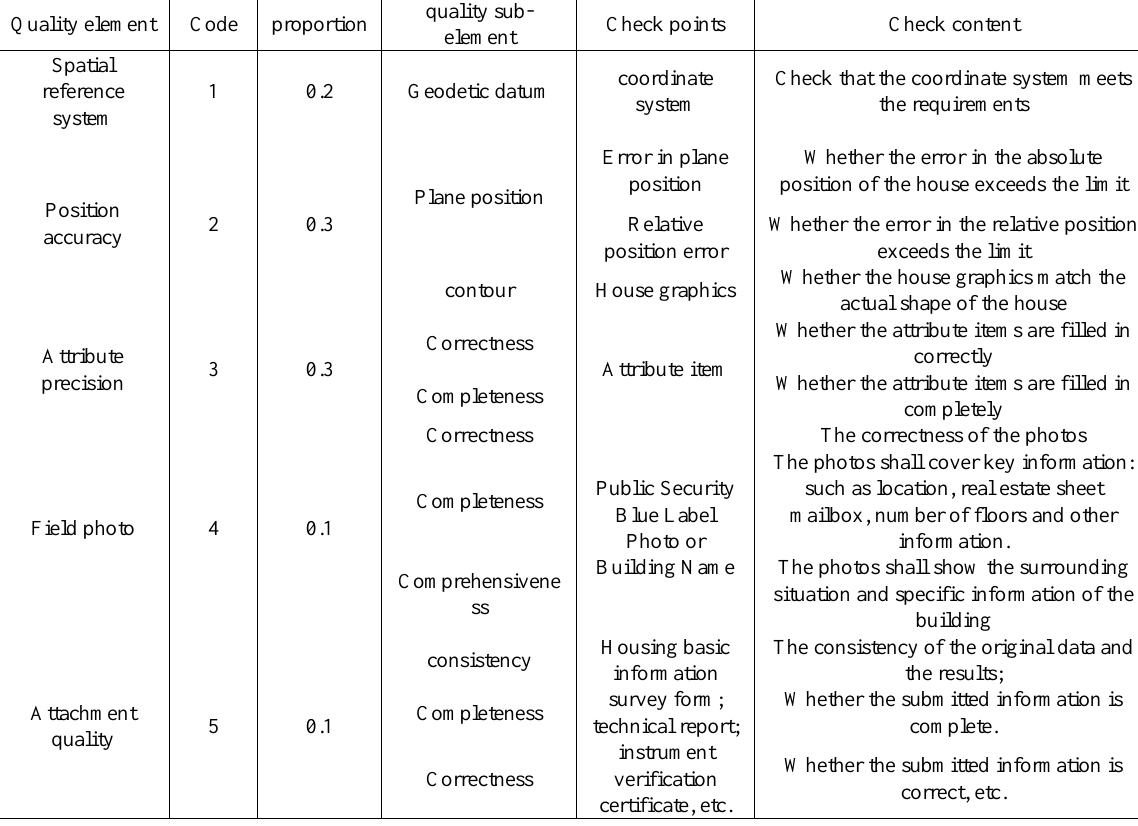
Table 3 . Contents and methods of field survey and surveying and mapping results